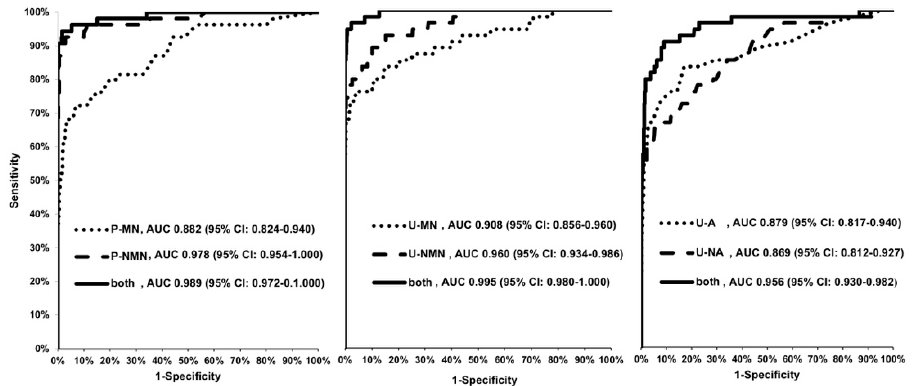
Figure 4. Area under the curve (AUC) of receiver–operator curve (ROC) of single parameters and of the combined model (pairs of metabolites).